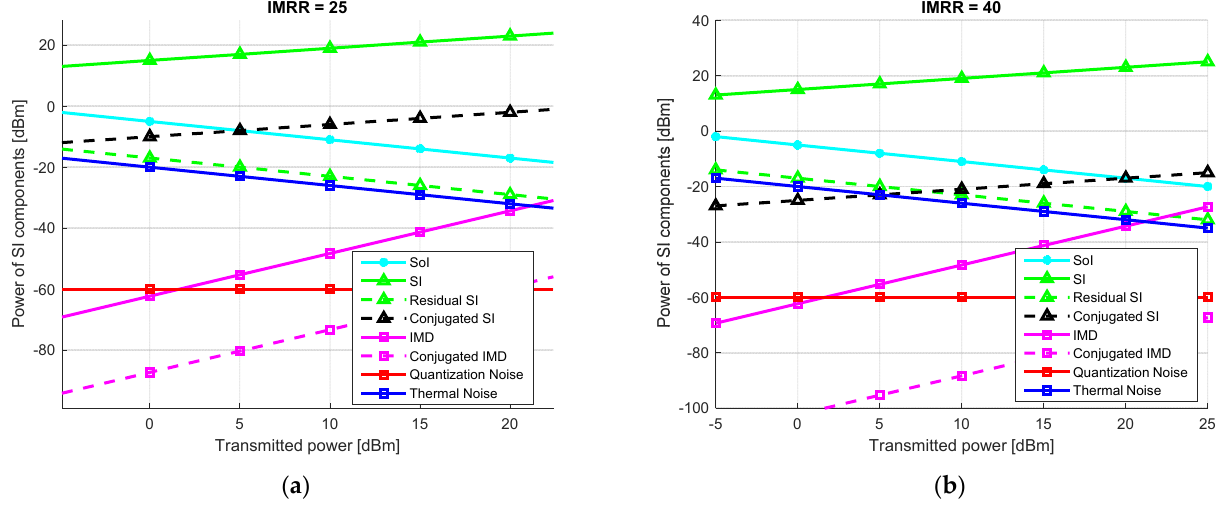
Figure 2. Power of SI components w.r.t. the transmitted power of an FD transceiver of ( a ) Type 1 ; ( b ) Type 2 .